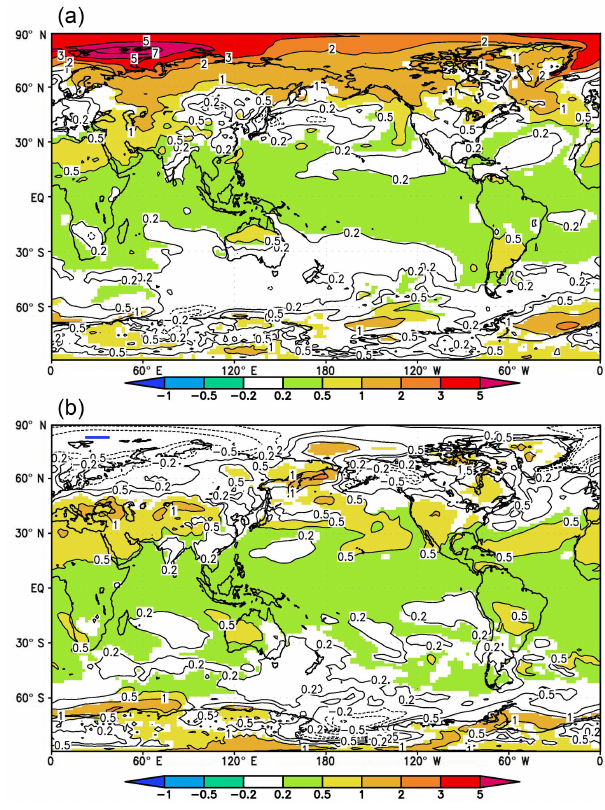
Figure 10. Annual mean near-surface air temperature (K) in 2000– 2014 minus 1985–1999 for the model run with highest (a) and low- est (b) warming in the Arctic. Shading represents the 99% level of